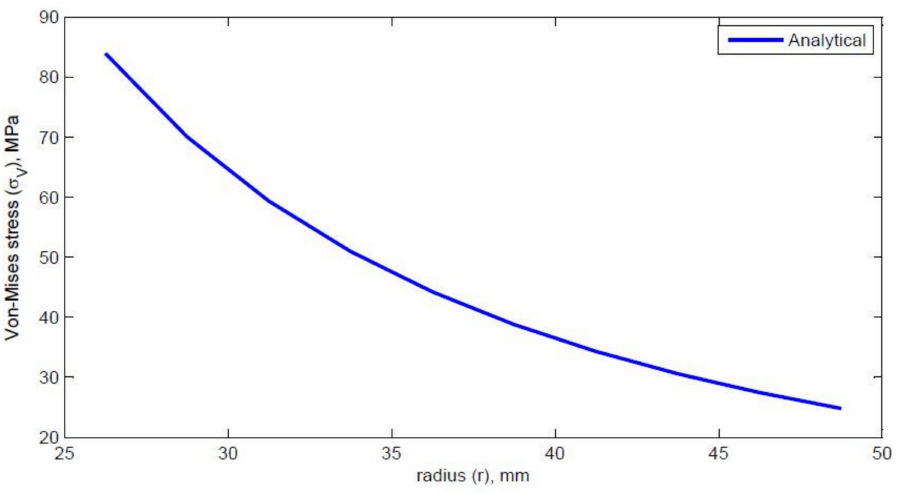
Figure 3. Von Mises stress vs. radius.